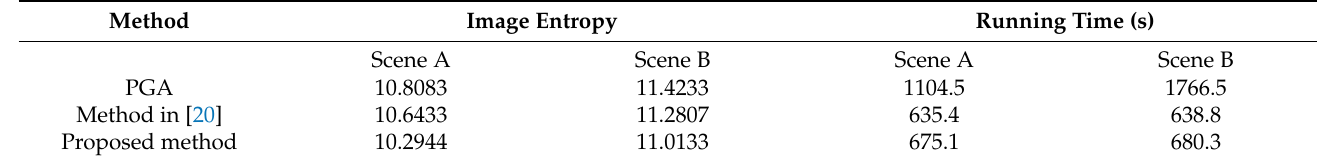
Table 2. Image entropy and running times of different imaging